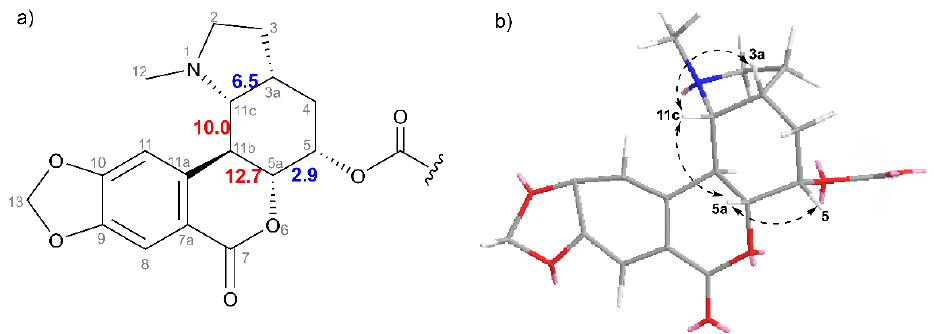
Figure 4. Determined relative configuration of unit A ( 3 ). ( a ) Values of J -coupling (given in Hz): highlighted in red represent the trans -orientation of coupling partners, while the blue color symbolizes the cis -orientation. ( b ) Stick presentation of unit A with NOESY correlations shown by dashed arrows.